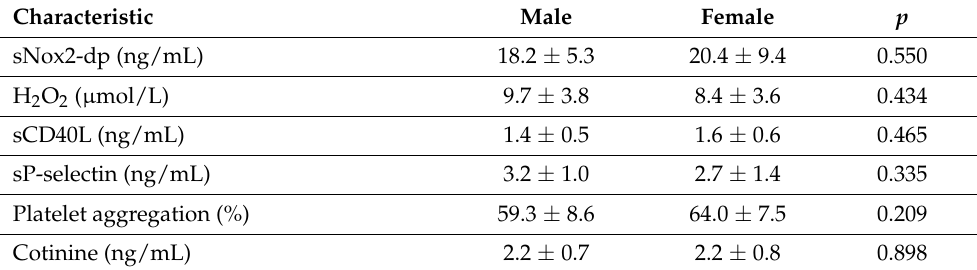
Figure 2. sNox2-dp circulating levels in the different sub-populations. Box-and-whisker plots rep- resenting sNox2-dp circulating levels (ng/mL) in the overall cohort and in non-smokers, TCCs-